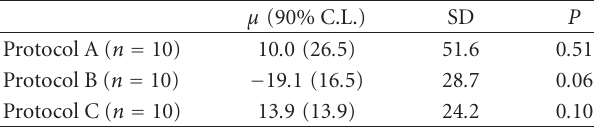
Table 2: Comparison of statistics for c 1 among decellularization protocols. Italics indicate statistical significance ( P < . 05). Values shown as percentages.